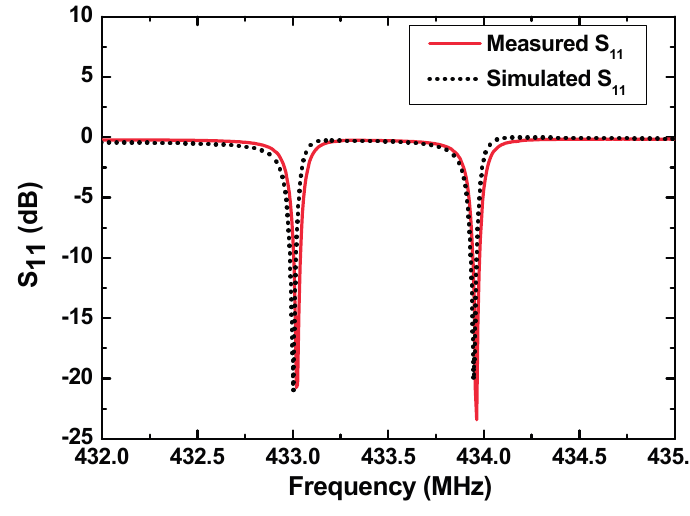
Figure 6. Simulated and measured S 11 of the SAW